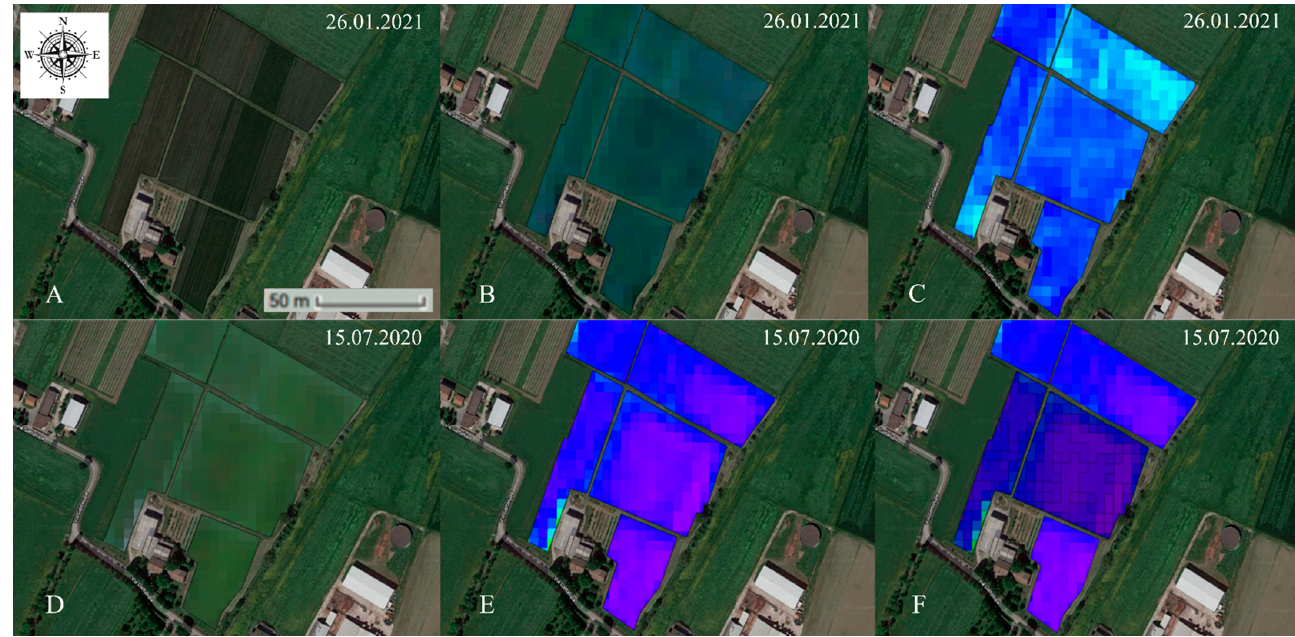
Figure 4. Sentinel-2 images accessed through Google Earth Engine (GEE). ( A ) Area of interest, ( B ) RGB field composition, ( C ) NDVI raster tile, ( D ) RGB field composition, ( E ) NDVI raster tile, ( F ) NDVI vector tile (Images facilitated by Graniot).